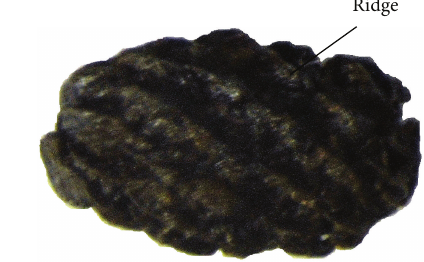
Figure 1: Egg of Cryptocephalus rufipes (Goeze, 1777), scale = 0.5 mm.